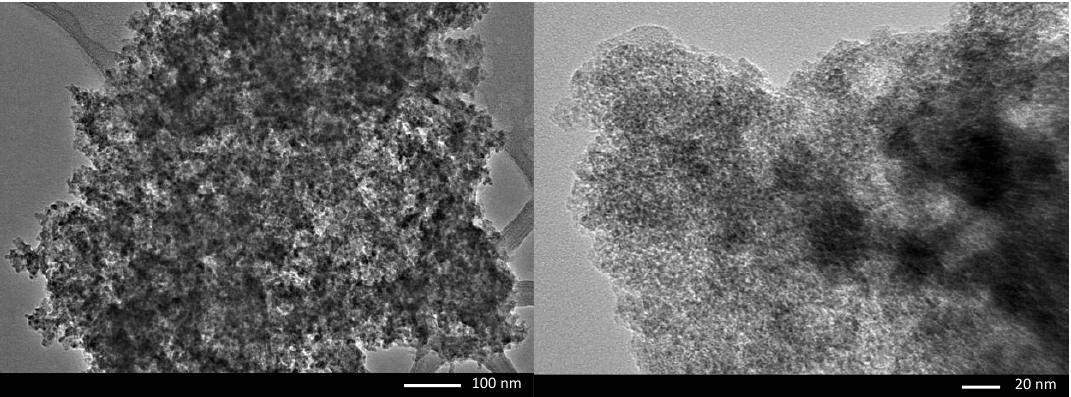
Figure 2. The HRTEM micrographs of the FMS powder adsorbent.